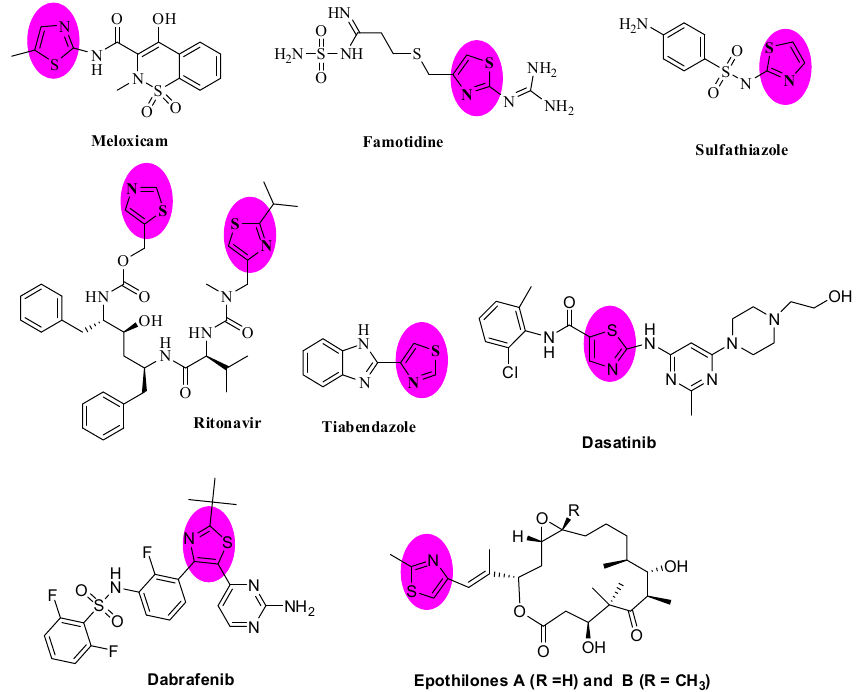
Figure 1. Commercial drugs containing a thiazole ring. Pyrazole derivatives have been reported as antimicrobial [19], analgesic [20], anti- inflammatory [21], and anticancer agents [22]. Additionally, many pharmaceutical drugs contain the pyrazole moiety, such as the antidepressant fezolamine and the anti-inflammatories celecoxib, mepirizole, and lonazolac. Moreover, the pyrazole derivative pyrazofurin has been reported to have antiviral [23,24] and anticancer activities [24,25]. Figure 2 depicts some of the most potent drugs containing a pyrazole ring.